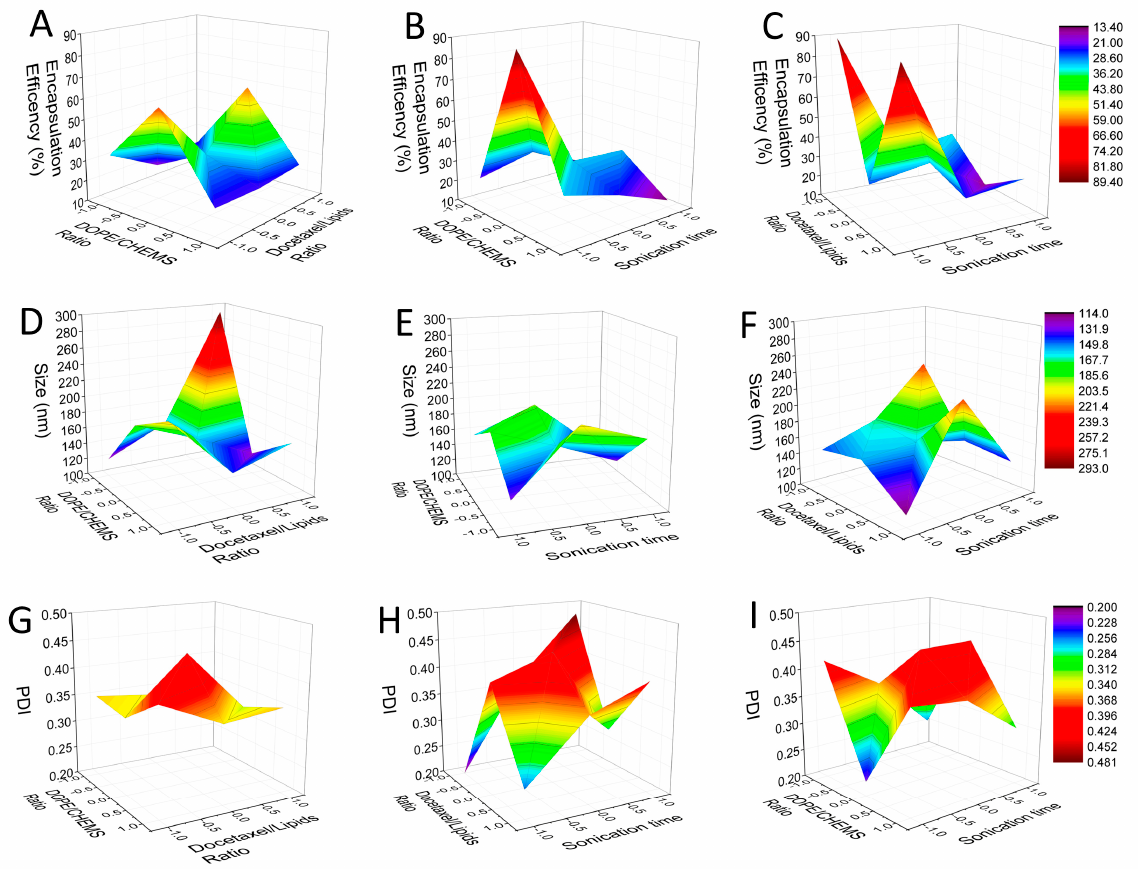
Figure 1. Response surface plots showing the effects of various formulation parameters on the responses encapsulation efficiency (Y 1 ), particle size (Y 2 ) and polydispersity index (Y 3 ). The ( A – C ) response surface plots relate DOPE/CHEMS ratio (X 1 ), docetaxel/lipid ratio (X 2 ) and sonication time (X 3 ) to encapsulation efficiency (Y 1 ). The ( D – F ) plots to the effects of X 1 , X 2 and X 3 on particle size (Y 2 ), and ( G – I ) to the effects of X 1 , X 2 and X 3 on the polydispersity index (Y 3 ).